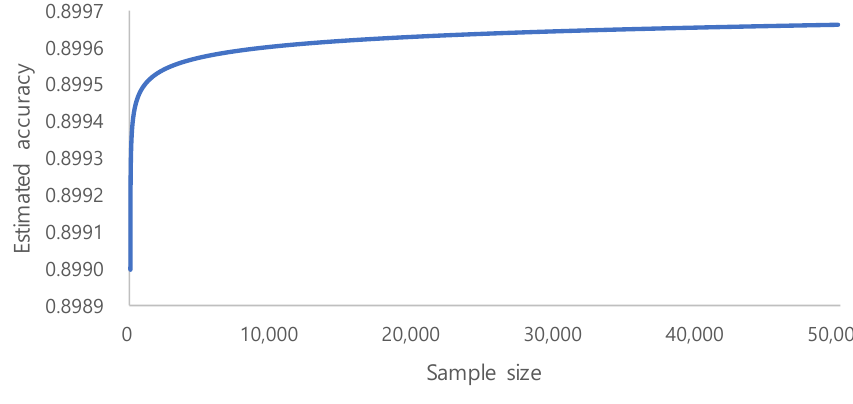
Figure 5. The trend of the accuracy as the number of training examples